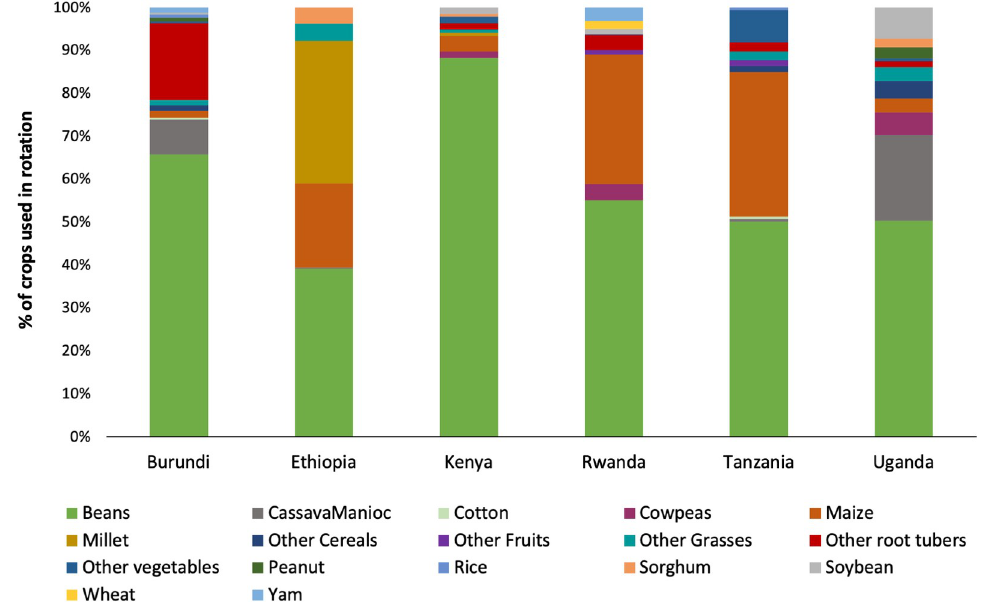
Fig 5. Proportion of crops used in rotation cropping system in the study districts of six eastern African countries.